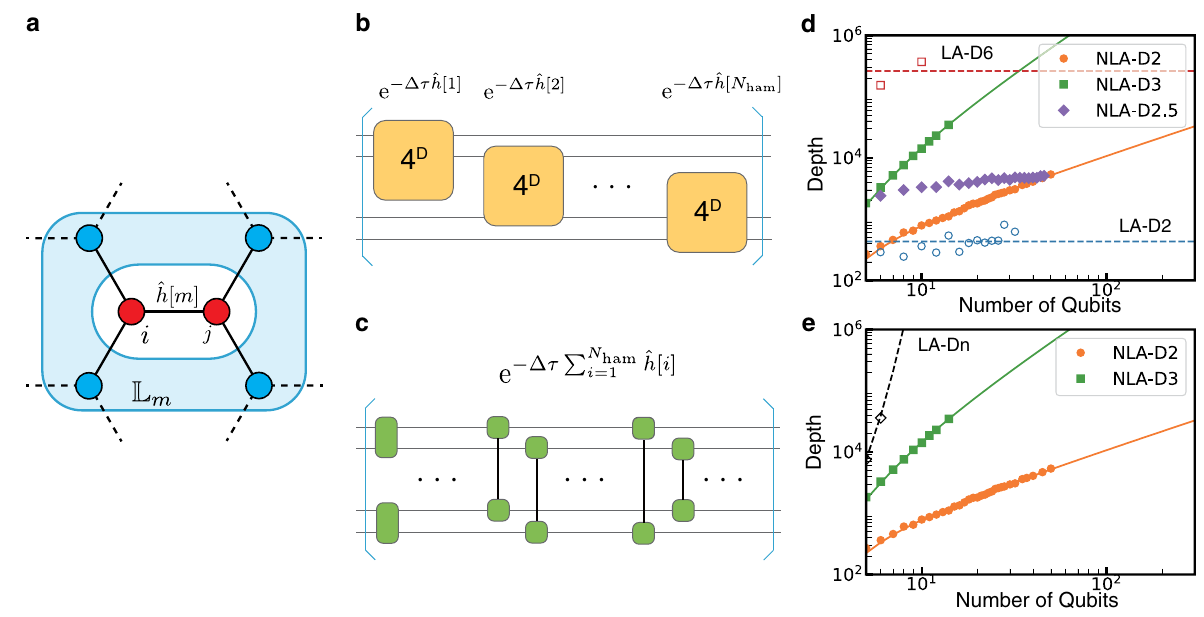
^ Fig. 1 Quantum circuit diagrams and quantum circuit depth. a Schematic of a 3-regular graph. A partial Hamiltonian h ½ m (cid:2) acts on qubits ^ h ½ m (cid:2) / ^ σ Z ; i (cid:5) ^ σ Z ; j . Outer blue vertices represent a domain directly connected to the red vertices. Blue represented with red vertices, i.e., vertices contained in the pale blue region comprise the set L m in Eq. (3). b Quantum circuit diagram for one imaginary-time step of LA. The horizontal line represents each qubit, and the yellow box represents 4 D gating operations on the straddling qubits. c Quantum circuit diagram for one imaginary-time step of the NLA (domain size D = 2). The green boxes and vertical lines connecting them represent a second-order C D of second-order tensor products. tensor product operation on the two straddling qubits, with one imaginary-time step containing N bit Detailed quantum circuit of the two-qubit unitary gate is described in Supplementary Note 2. The dependence of the quantum circuit depth for one imaginary-time step of the max-cut problem in the 3-regular graph ( d ) and the fully connected graph ( e ) as a function of the number of